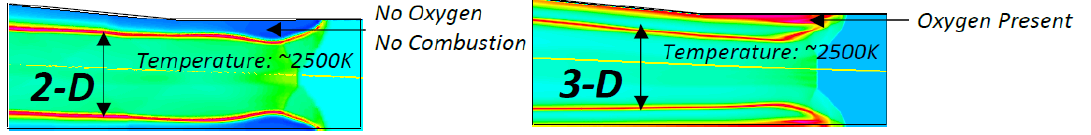
Figure 13. Two-dimensional (2-D) vs. three-dimensional (3-D) jet into crossflow, temperature contours (K).